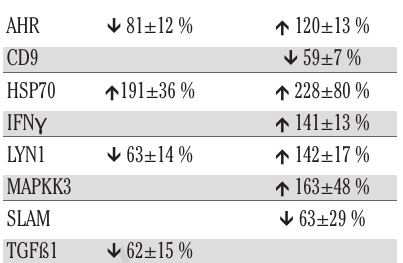
Table 2. Summary of significant gene expression changes in the 11B7501 B lym- phoma cell line. Up- or downregulation is described as the percentage of expression relative to the negative controls of ß2M. The ß2M negative control (-EE /-LPS) was 2 used to normalize genes exposed to EE 2 only, whereas the ß2M negative control (-EE /+LPS) was used to normalize genes 2 exposed to EE and LPS. 2 Genes 25 000 µg/L E